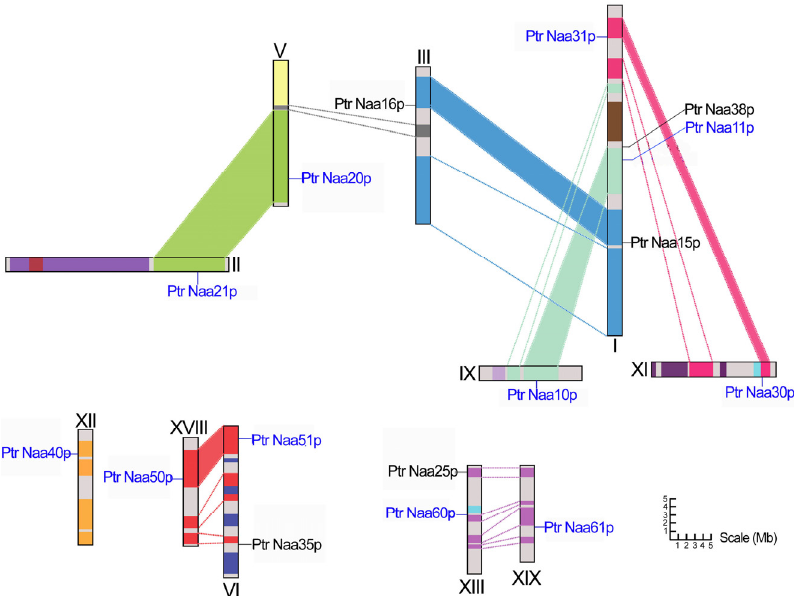
Figure 1. Chromosomal location of the Populus N -terminal acetyltransferase (Nat) catalytic subunit ( CS ) and auxiliary subunit ( AS ) genes. All sixteen genes are mapped to the 11 of nineteen Linkage Groups (LG). The schematic representation of genome-wide chromosome organization arising from the whole-genome duplication event in Populus was obtained from the study of Tuskan and its co-workers [12]. Segmental duplicated homologous regions are shown with the same color. Only the duplication blocks containing Nat CS and AS genes are connected with lines in shaded colors. The scale at the bottom represents a 5 Mb chromosomal